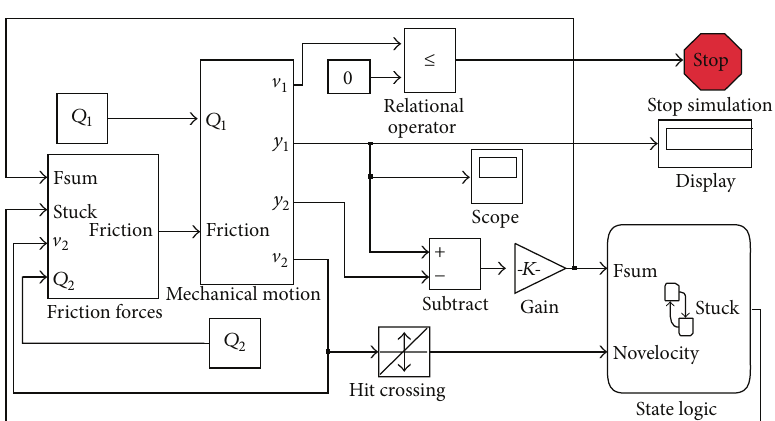
Figure 5: Braking dynamic simulation model of energy absorber.